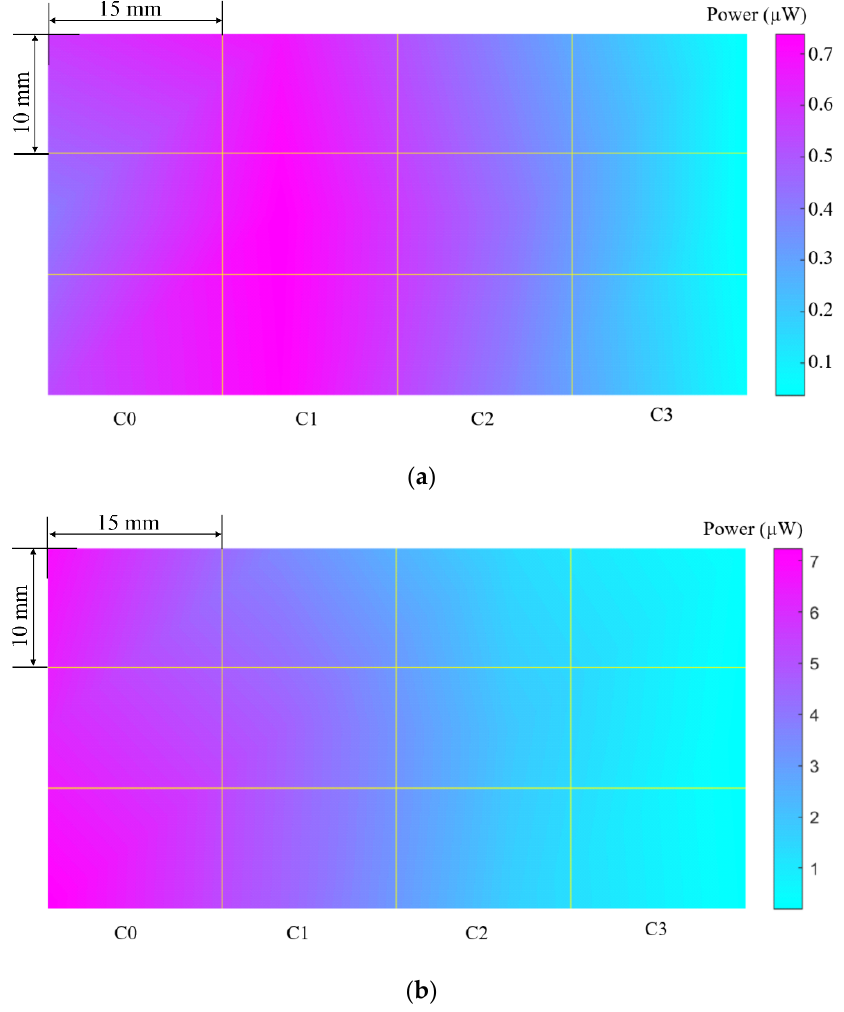
Figure 12. Mapping of the output power of PEH excited by a sinusoidal wave with an amplitude of 5 V and frequency: ( a ) 20.8 Hz and ( b ) 25.4 Hz. 5 V and frequency: ( a ) 20.8 Hz and ( b ) 25.4